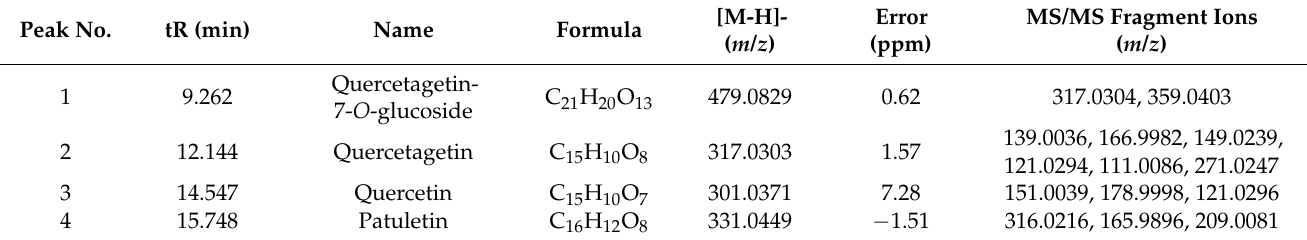
Table 2. Identified potential antioxidant compounds of the methanol extract of marigold. Peak No.